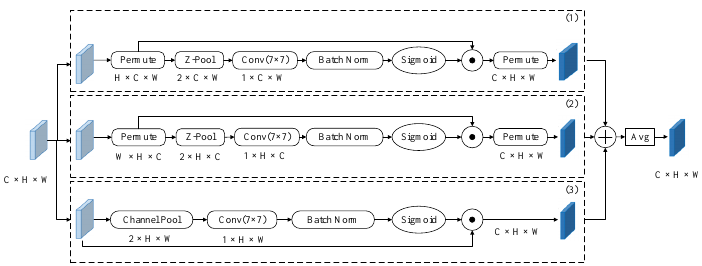
Figure 4. Illustration of the triplet attention, which has three branches. The first branch (1) is used to compute attention weights across channel dimension C and spatial dimension W. Similarly, the second branch (2) uses channel dimension C and spatial dimension H. The final branch (3) is used to capture spatial dependencies (H and W). Finally, the weights are aggregated by simple averaging.